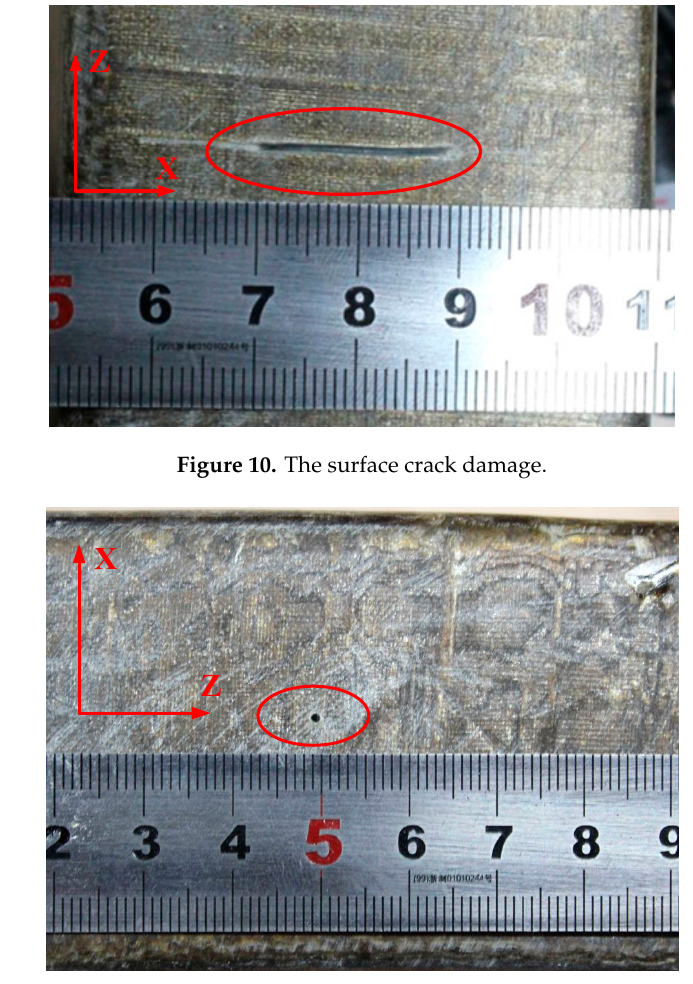
Figure 11. The longitudinal crack damage.